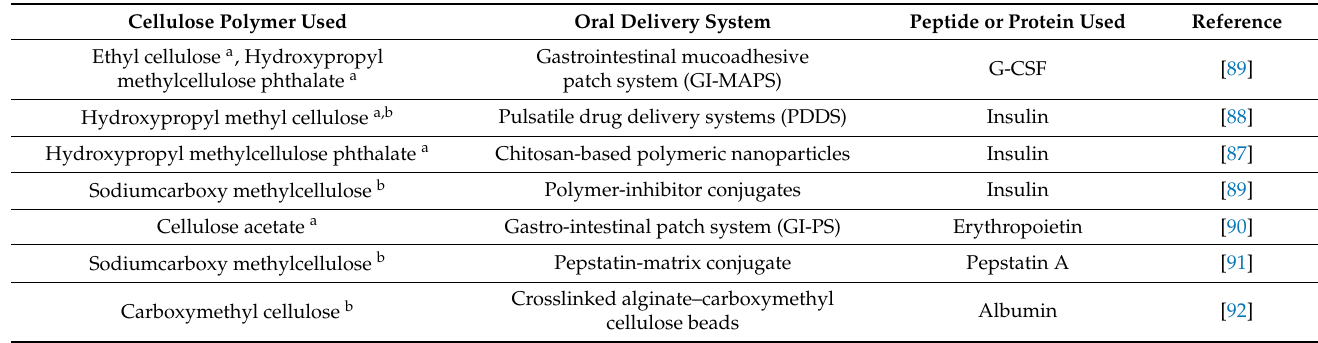
Table 3. Examples of cellulose polymers used in the oral delivery of peptides and